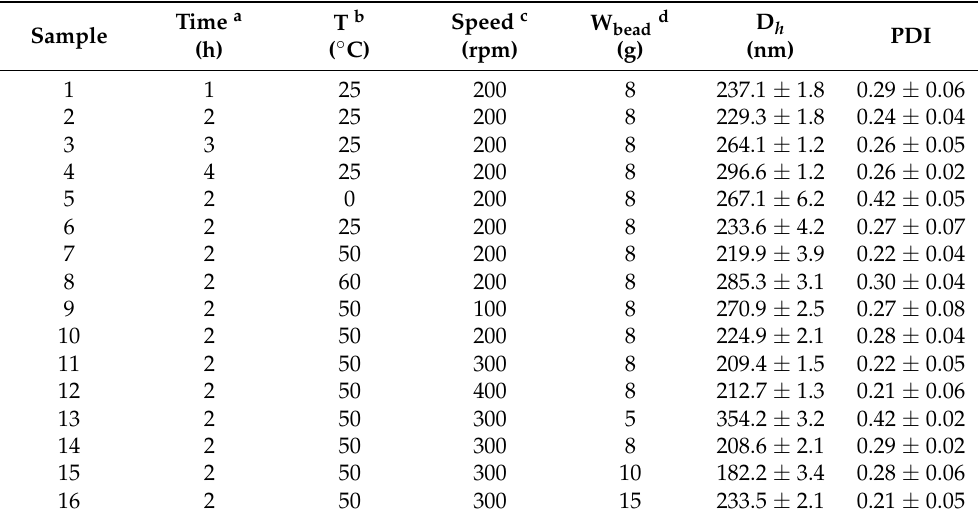
Table 2. Effect of time, temperature, speed, and the amount of milling media on the size and size distribution of NRG